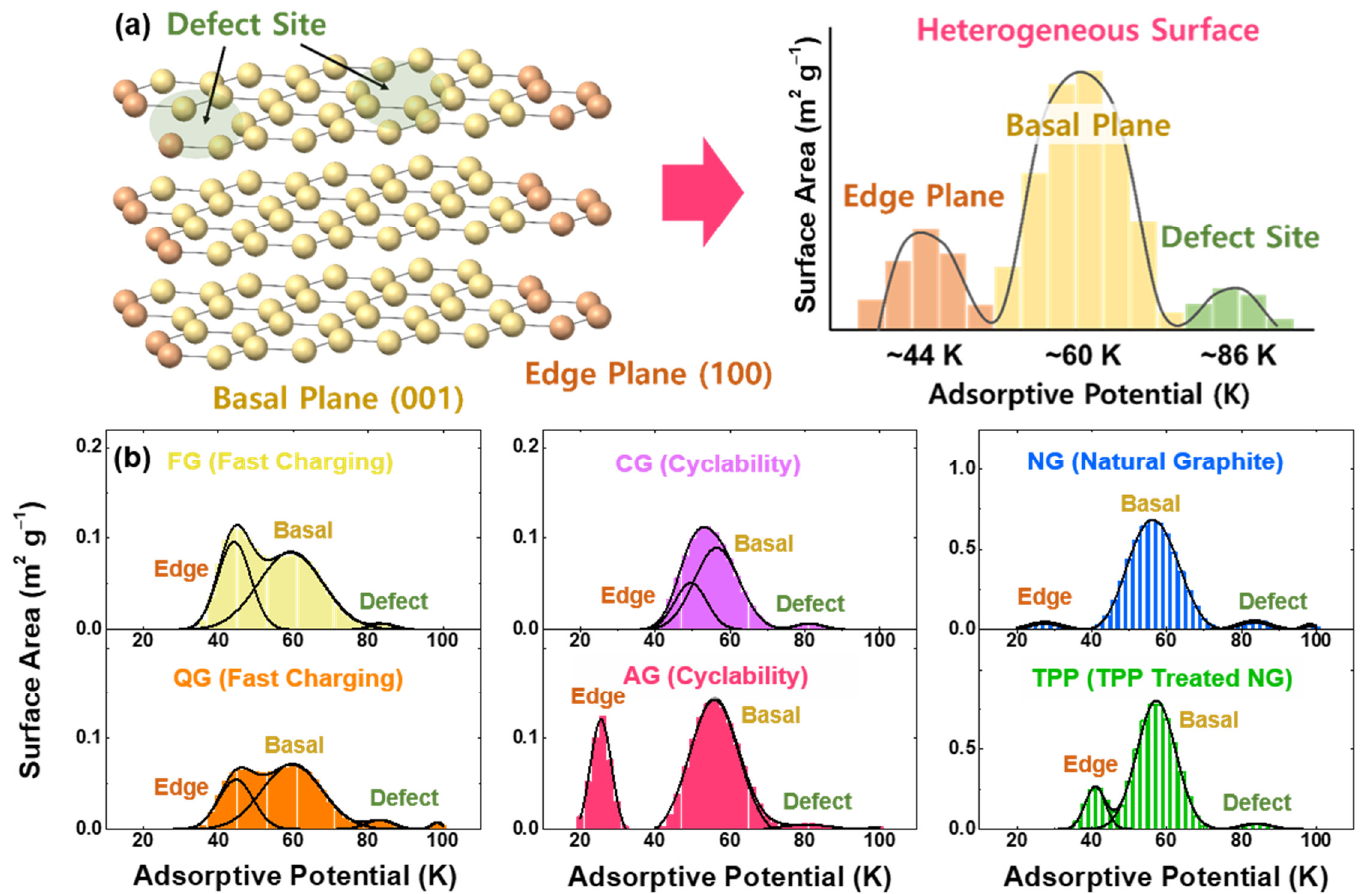
Figure 1. N 2 adsorption on different kinds of graphite surfaces. ( a ) Schematics for the adsorption-potential distribution of heterogeneous graphite surfaces. ( b ) Surface area as evaluated by the adsorption energy. The characteristics of four artificial-graphite and two natural-graphite powders are as follows: FG (fast-charging), QG (fast-charging with high specific capacity), CG (cyclability), AG (artificial graphite), NG (natural spherical graphite), and TPP (triphenylphosphine-treated NG).